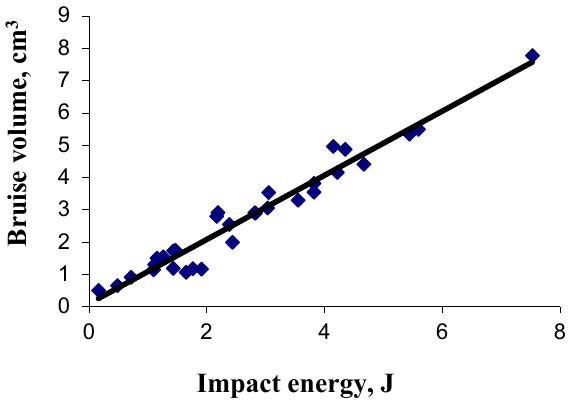
Figure 12. Bruise volume vs. impact energy for cantaloupe.